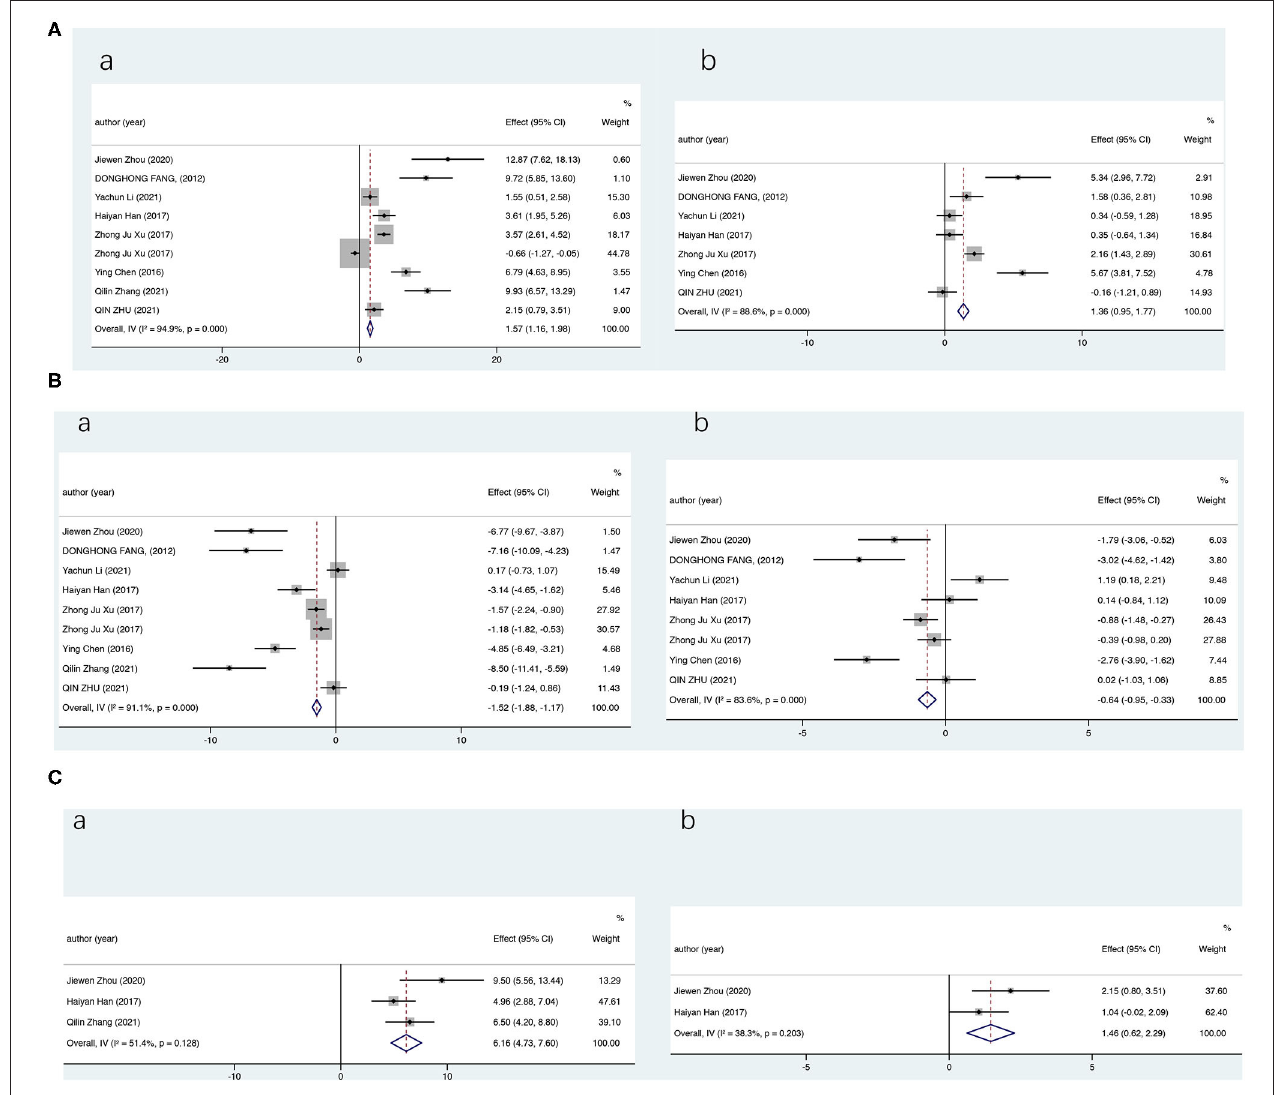
FIGURE 2 | Overall analysis results (CI). Summary estimates were analyzed using a random-effects model. (A) For superoxide dismutase (SOD), (B) For malondialdehyde (MDA), and (C) For glutathione peroxidase (GSH-Px) [(a) vs. the model group and (b) vs. the Western medicine